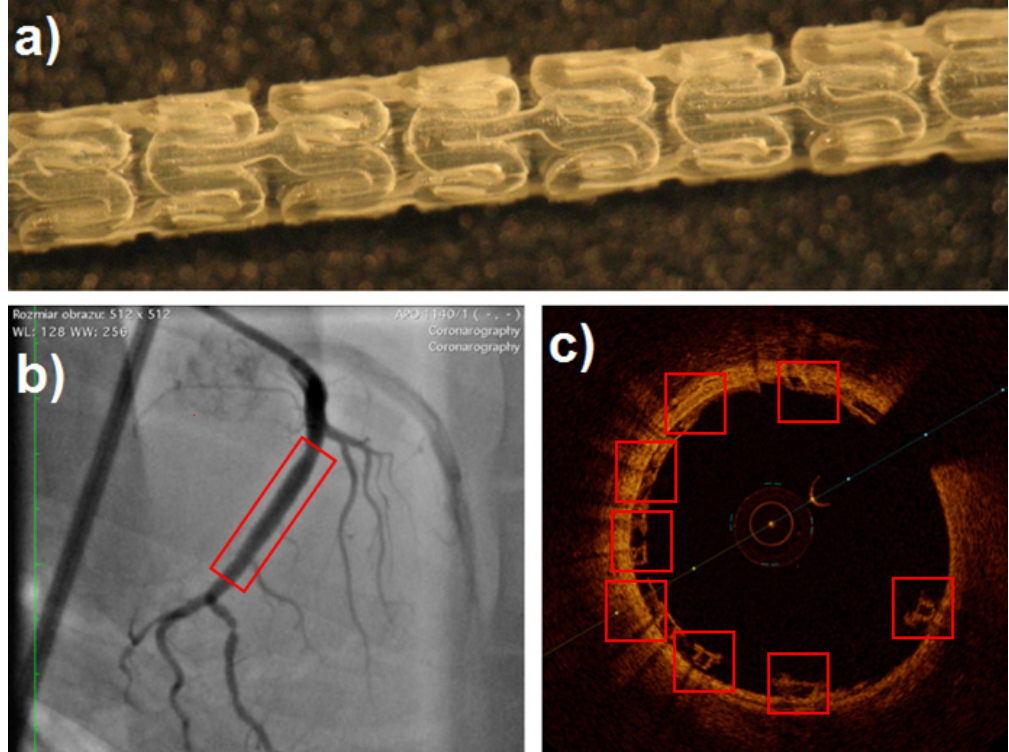
Figure 15. One of the test variants of a bioresorbable coronary stent developed with the use of the proposed constitutive methodology within the Apollo STRATEGMED2 project: ( a ) Stent after cutting and free compression; ( b ) area of clinical test implementation (angiography image); ( c ) area of clinical test implementation (intravascular ultrasound image)